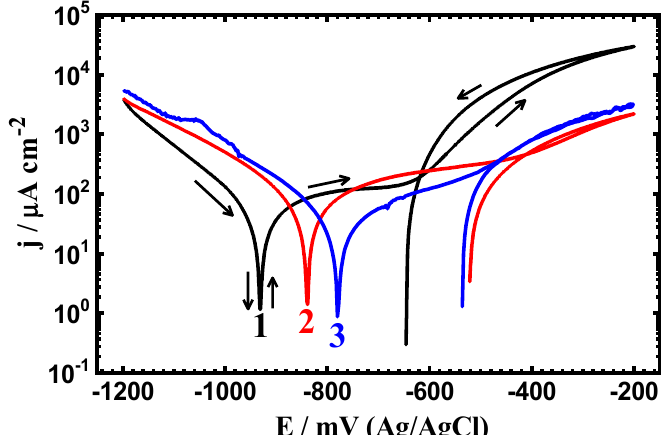
Figure 5. Cyclic potentiodynamic polarization (CPP) measurements obtained for (1) PS, (2) PSC1, and (3) PSC2 in 4% NaCl solution after 1.0 h of exposure.